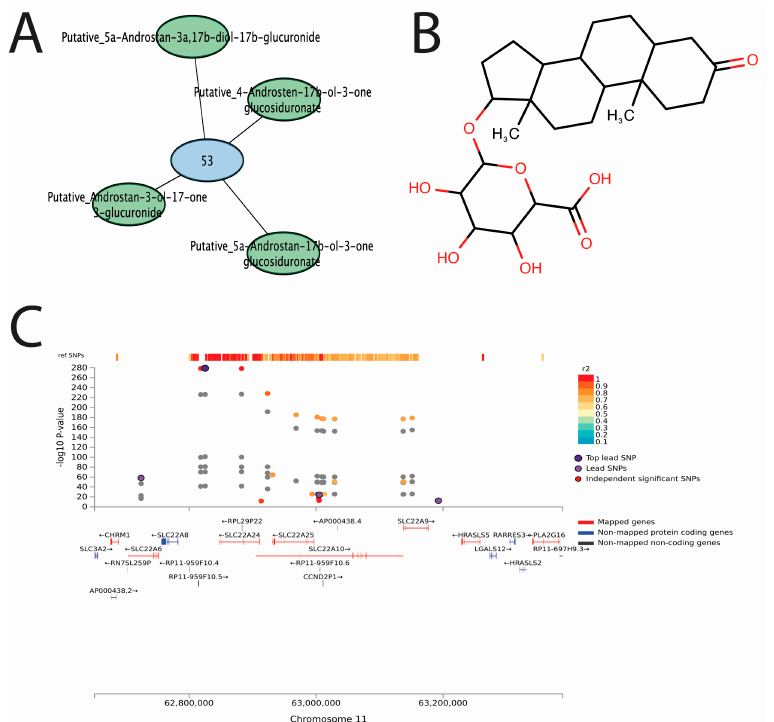
Figure 8. Genomic locus 53, containing SLC22 genes, is associated with conjugated sex steroid hormones. ( A ) The SLC22 genes, SLC22A6 , SLC22A8 , SLC22A9 , SLC22A10 , SLC22A24 , and SLC22A25 are highly associated with circulating levels of 5a-Androstan-17b-ol-3-one glucosiduronate, 4a-Androstan-17b-ol-3-one glucosiduronate, Androstan-3-ol-17-one 3-glucuronide, and 5a-Androstan- 3a,17b-diol-17b-glucuronide. The specific associations between SNPs and identified metabolites are listed in Supplementary Table S4. ( B ) The chemical structure of 5a-Androstan-17b-ol-3-one glucosiduronate is shown as a representative example of the metabolites potentially regulated by these transporter genes. ( C ) The SNPs shown are associated with the levels of any implicated metabolites, where purple points refer to the top lead SNP, and other SNPs are represented by points colored by their r2 value. The r2 value, which represents phenotypic variation, is high in these regions and reference SNPs that have previously been analyzed. The nearest mapped genes are shown below each plot. SNPs, which are not in linkage disequilibrium of any significant independent lead SNPs in the selected region, are colored grey.